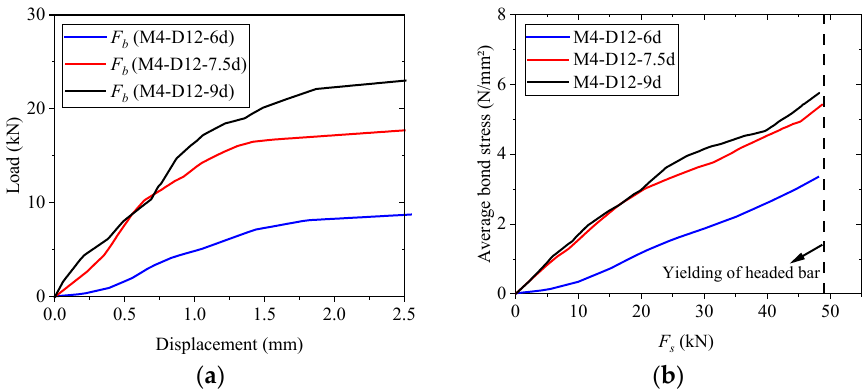
Figure 20. Bond behavior with different lap length ( a ) Bond force; ( b ) Average bond stress.